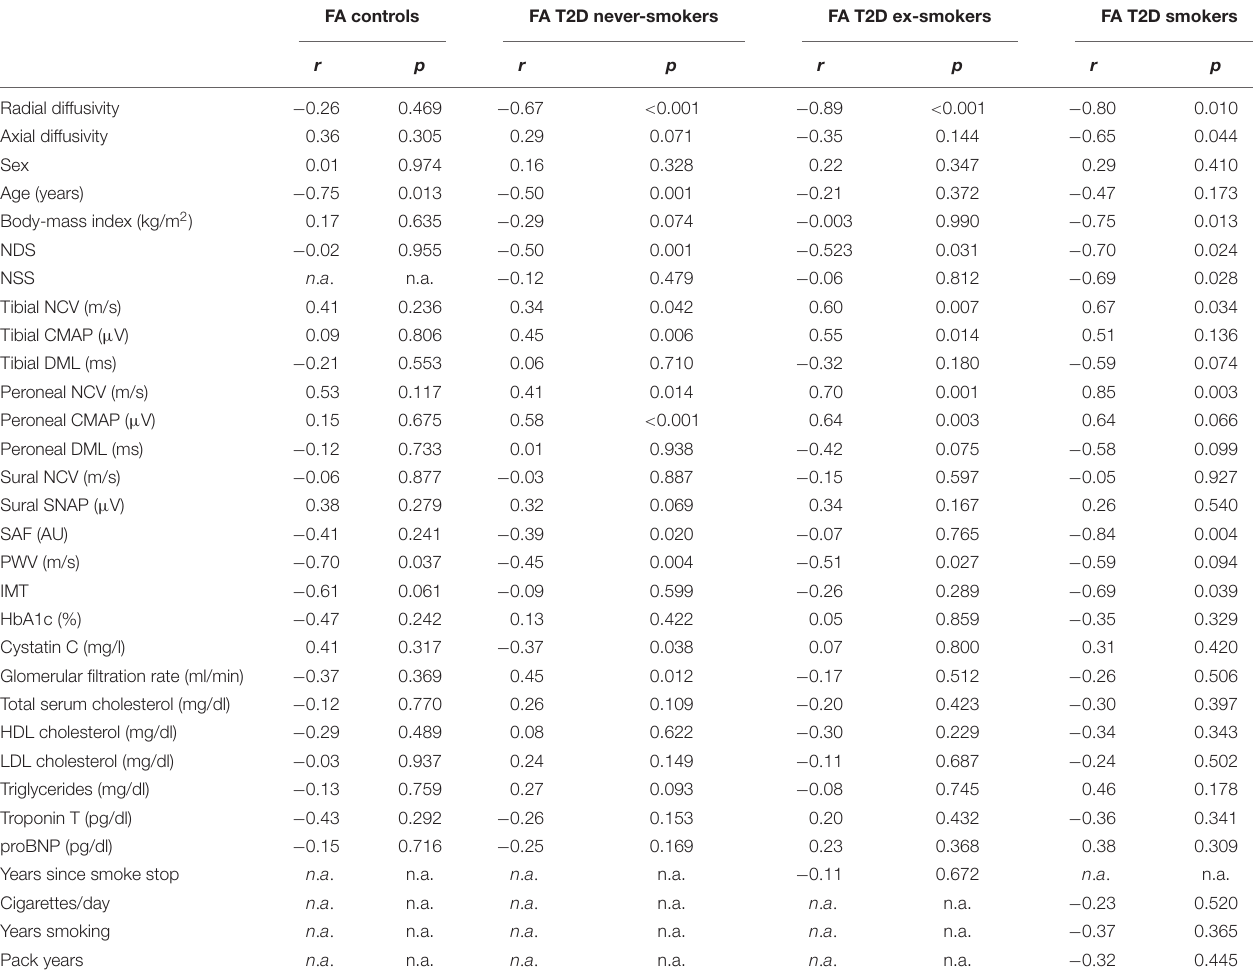
TABLE 2 | Correlation of the sciatic nerve’s fractional anisotropy (FA) with demographic, clinical, apparatus-bound, and serological parameters. FA controls FA T2D never-smokers FA T2D